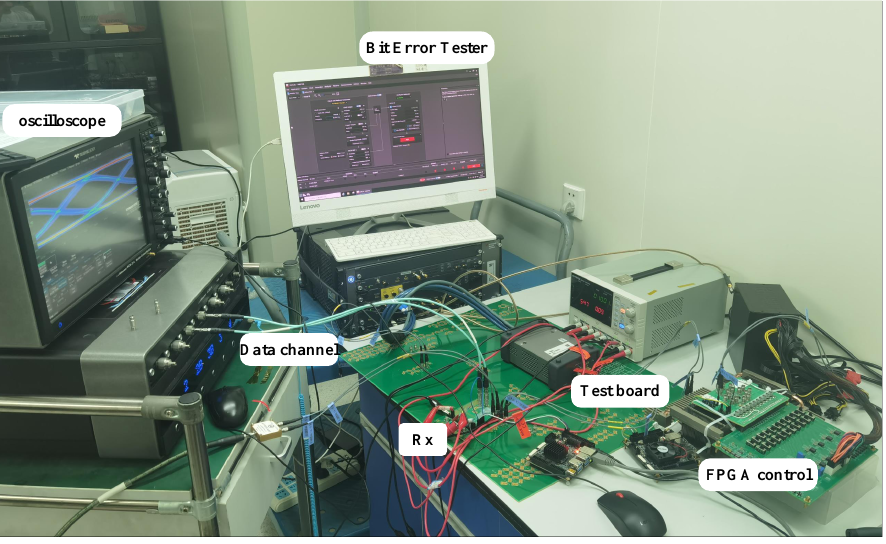
Figure 8. Pre-equalization test